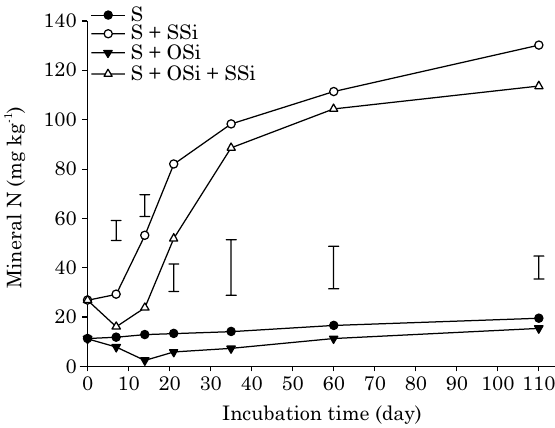
Figure 3. Amounts of mineral N during the incubation of sewage sludge (SS) and oat straw (OS) incorporated (i) into soil (S) combined or alone. Vertical bars represent the minimum significant difference between treatment means (Tukey at 5